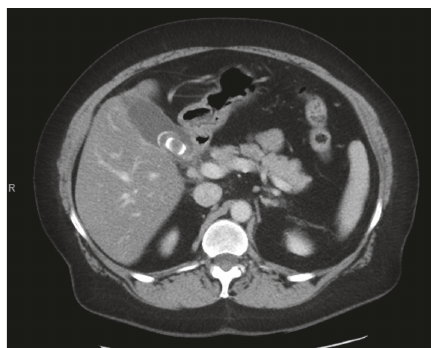
Figure 2: Preoperative CT abdomen with cholelithiasis and duode- nal wall thickening.